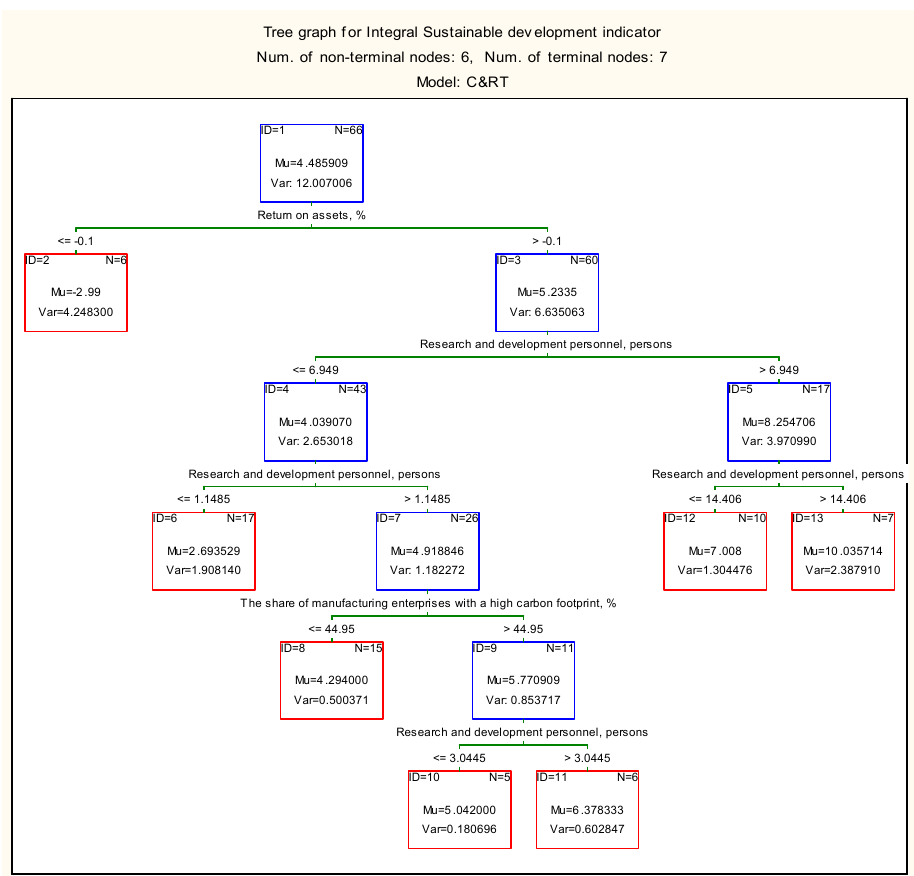
Figure 6. Regression tree for identifying patterns of sustainable development of innovative mesosys- tems in industry (based on continuous forecasting).